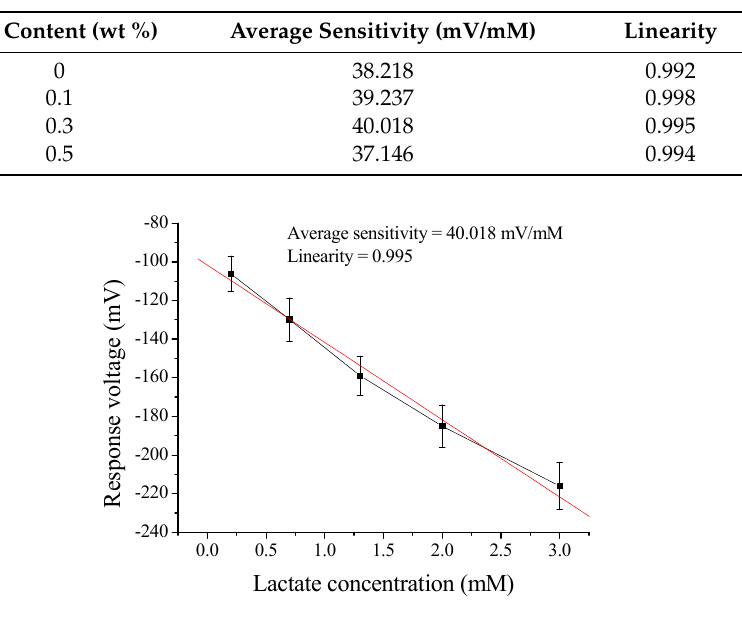
Figure 4. The response voltages of flexible arrayed lactate biosensor modified by 0.3 wt % GO.